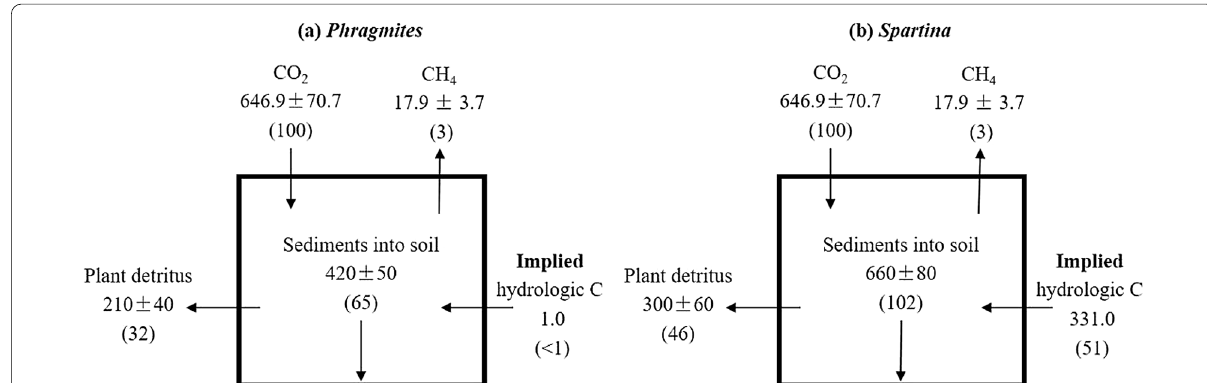
Fig. 6 Average annual C budget in coastal wetlands dominated by Phragmites ( a ) and Spartina ( b ), including the net ecosystem CO 2 exchange (NEE), net ecosystem CH 4 exchanges (CH 4 ), lateral detrital C flux (plant detritus), and sediments into the soil. The net uptake/loss values imply the net hydrologic C fluxes (i.e., DOC, POC, and DIC). All observed fluxes are presented as absolute values (g C m − 2 year − 1 , and the arrows indicate the flux direction. The values in parentheses indicate the relative magnitude (%) of each flux normalized with the NEE